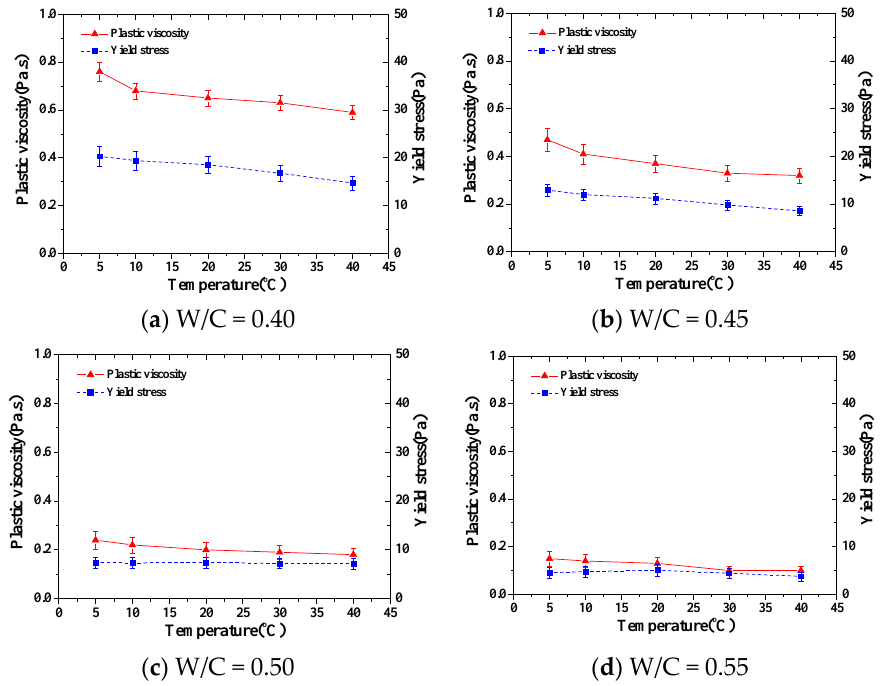
Figure 3. The rheological parameters of different cement pastes by mixing ratios.